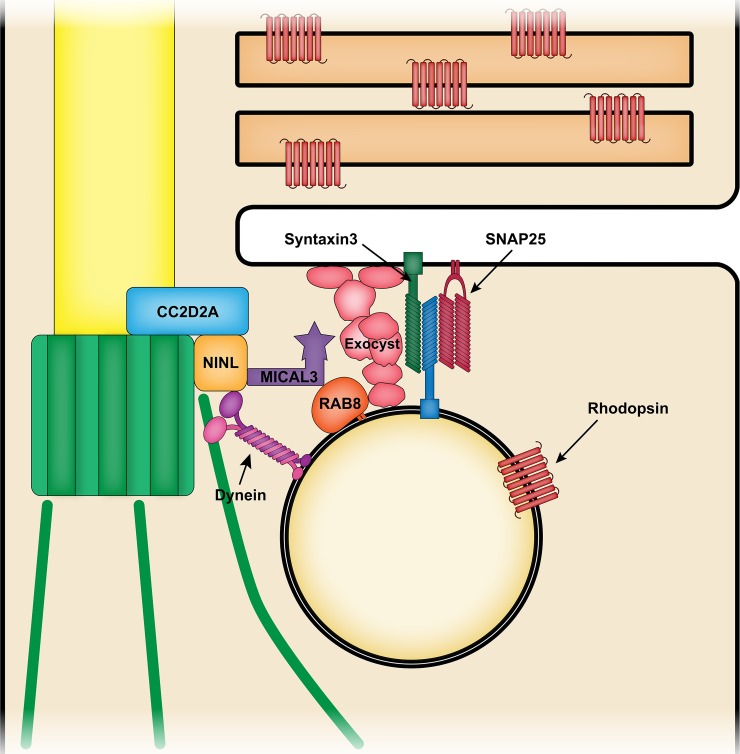
The role of CC2D2A in opsin-carrier-vesicle fusion at the periciliary membrane.Rab8 coats opsin-carrier-vesicles and targets them to the periciliary membrane, where their fusion is mediated by the Exocyst and by SNAREs including SNAP25 and Syntaxin 3 (and by an as yet undefined v-SNARE). CC2D2A at the transition zone is required for correct localization of SNAP25 to the periciliary membrane and provides a docking point for incoming vesicles through its interaction with NINL, which also binds the dynein motor and the Rab8 effector MICAL3. Thus, CC2D2A plays a role in concentrating all components required for correct vesicle fusion at the periciliary membrane.